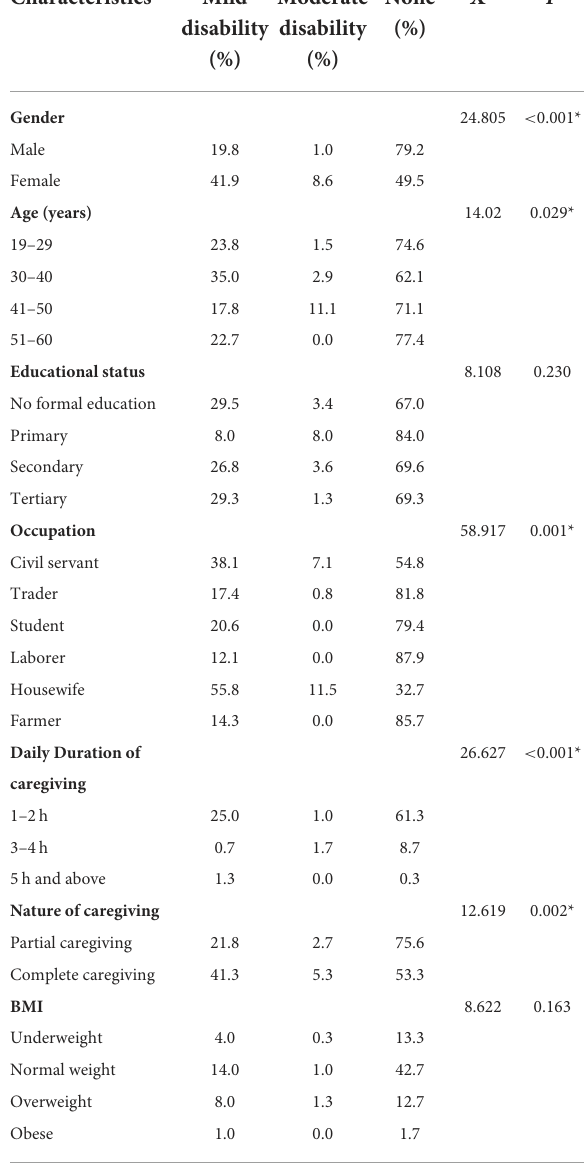
TABLE 2 Association between presence of LBP among caregivers of stroke survivors and demographic and clinical variables. Variables